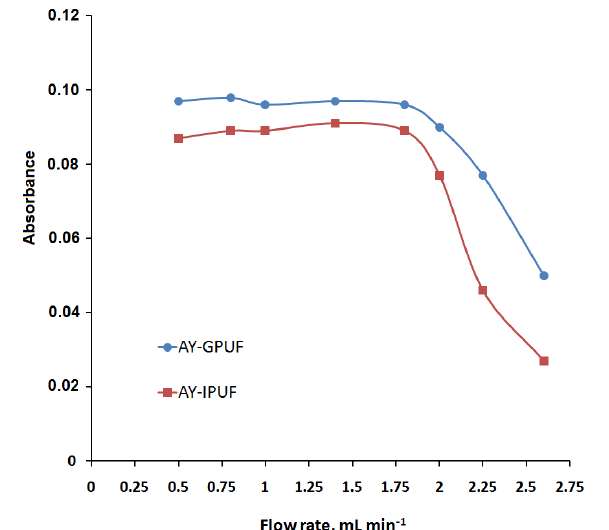
FIGURE 14 - Effect of sample’s flow rate on the adsorption of CAF onto AY-GPUF and AY-IPUF sorbents.